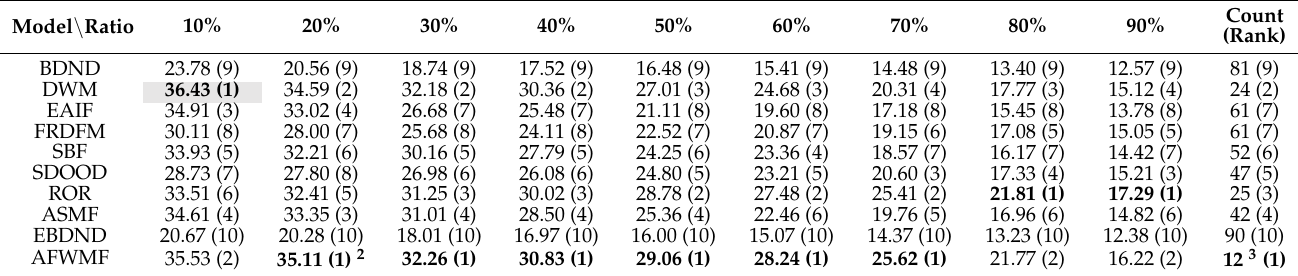
Table 3. The PSNR value at different noise densities from different filters used for the Lena image. Model \ Ratio 10% BDND